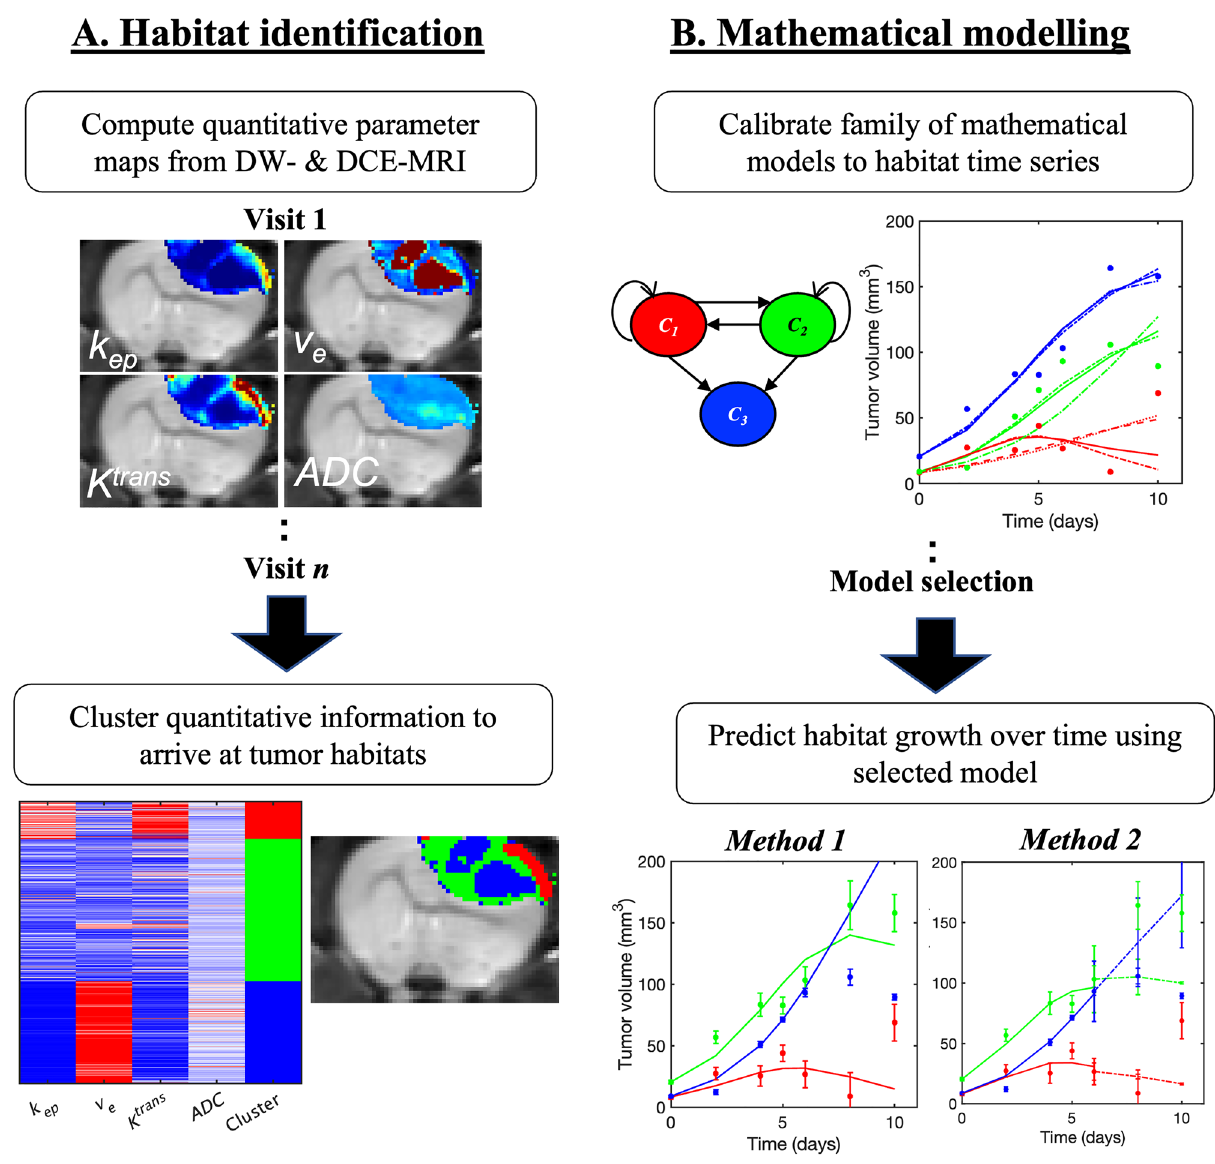
Figure 1. Habitat identification and modelling pipeline. ( A ) DCE-MRI and DW-MRI data were acquired for each animal over multiple days. The multiparametric MRI data were analyzed to generate four parameter maps (i.e., k ep , v e , K trans , ADC) across the tumor ROI (top left). The quantitative information at each voxel at all imaging visits for all animals was pooled together into one conglomerate feature matrix and then clustered to identify three tumor habitats with unique physiologies: high-vascularity high-cellularity, low-vascularity high-cellularity, and low-vascularity low-cellularity (bottom left). ( B ) Once the habitats were identified, each rat’s tumor was divided into three habitat time series that could be analyzed by a family of mathematical models based on three compartments and the transition rates between them (top right). We then tested the ability of the most parsimonious model to predict habitat dynamics through leave-one-out (Method 1) and bootstrapping (Method 2) analyses (bottom